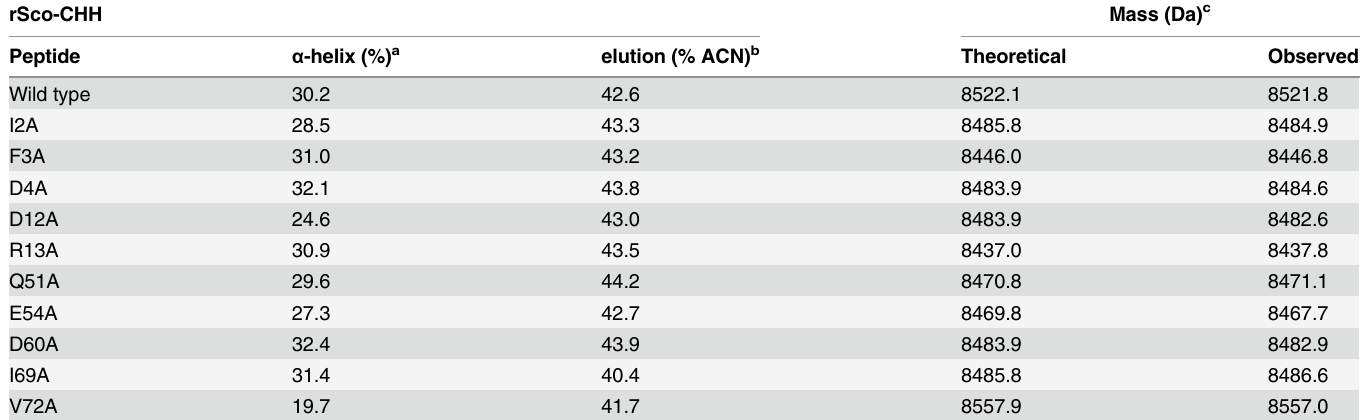
Table 1. Identification and characterization of wild-type and alanine-substituted rSco-CHH peptides. rSco-CHH